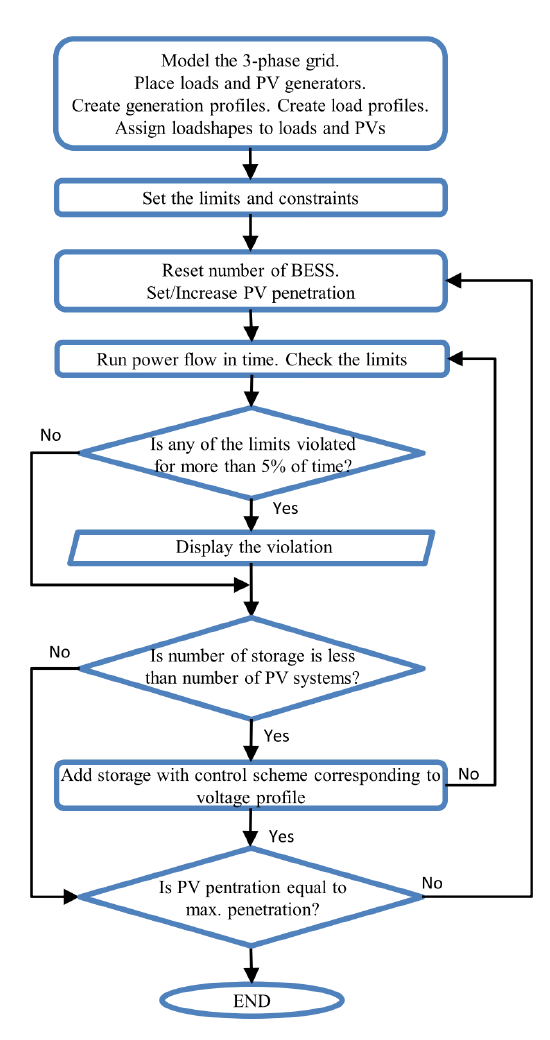
Figure 3. Flow chart of the algorithm to assess hosting capacity for the system with